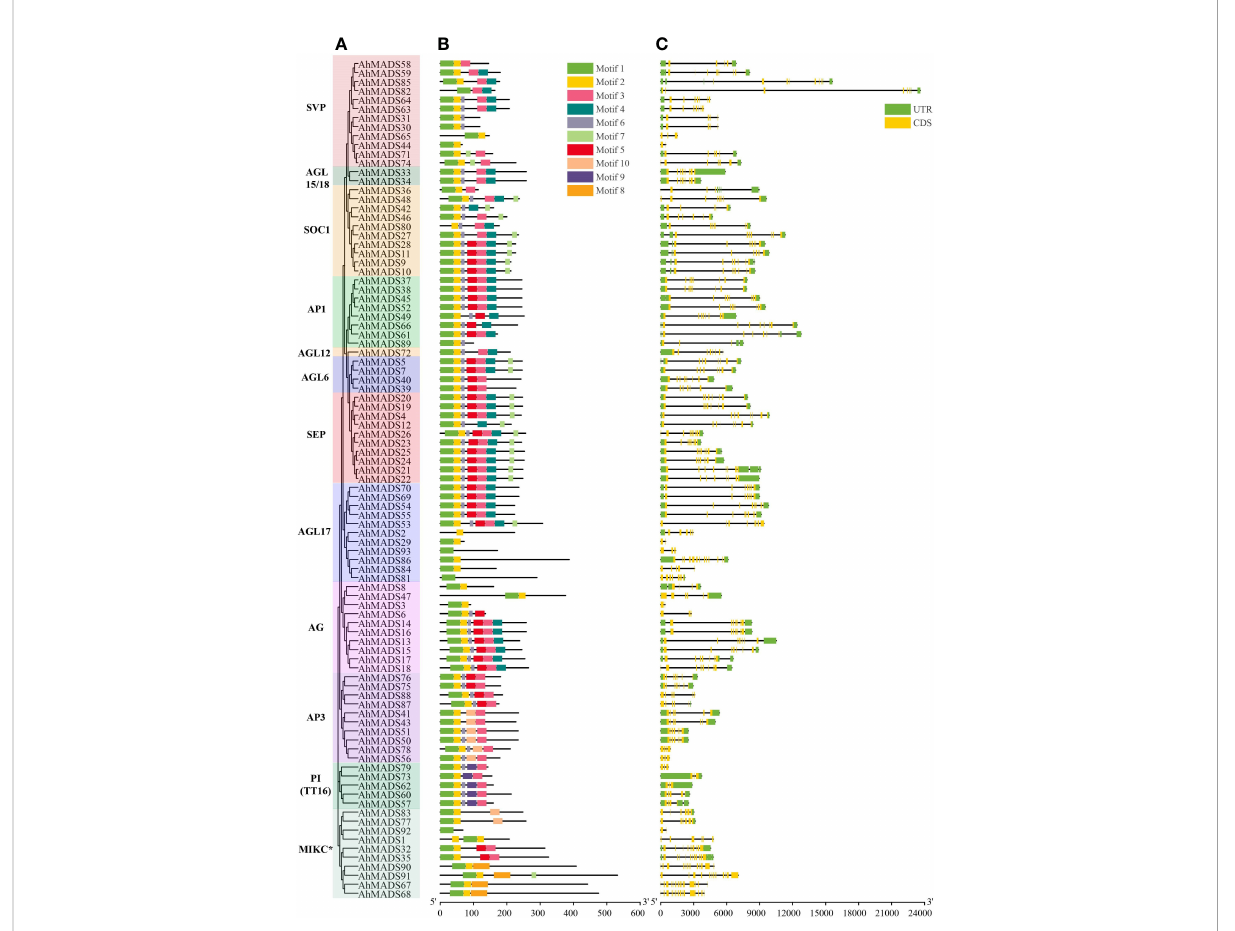
FIGURE 2 Phylogenetic relationship, conserved motifs, and exon − intron structure analysis of the MADS-box genes in peanut. (A) The maximum-likelihood phylogenetic tree was constructed using MEGA X with 1000 replicates. (B) Conserved motifs of MADS-box proteins. Ten conserved motifs are shown in different-colored boxes. (C) Exon − intron structures of MADS-box genes. The yellow boxes represent exons, and the black lines represent